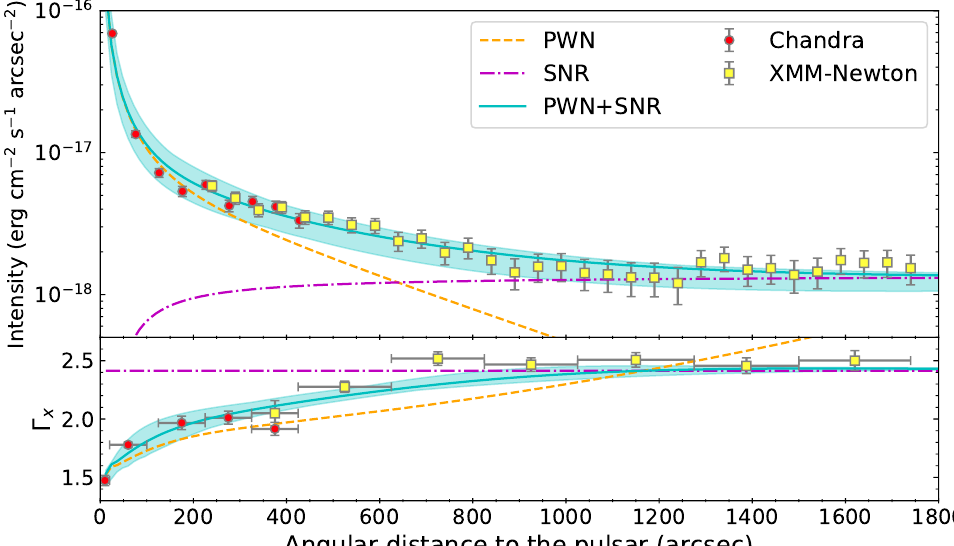
Figure 2. The fitting result of the radial profiles of X-ray surface brightness and photon index. The or- ange dashed line represents the PWN electron component, the purple dash–dotted line represents the SNR electron component, and the cyan solid line with a 1 σ error band is the sum of the two. Red and yellow data points are from Chandra and XMM-Newton, respectively, taken from Ge2021. Only statistic errors are